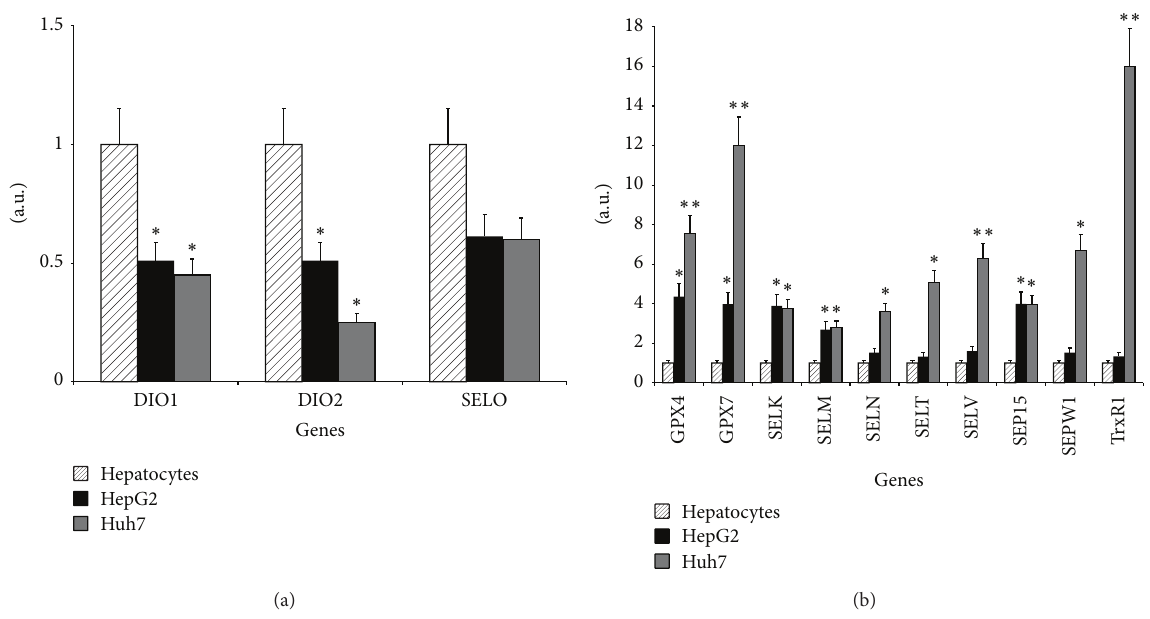
Figure 1: Expression of selenoprotein genes analyzed by means of RT-qPCR. The average value for the expression of these genes was obtained from three independent experiments. (a) shows the downregulated genes in HepG2 and Huh7 versus normal hepatocytes (DIO1, DIO2, and SELO) while (b) shows the ten upregulated genes (GPX4, GPX7, SELK, SELM, SELN, SELT, SELV, SEP15, SEPW1, and TrxR1). In each reaction, the expression levels were normalized to the average of the control gene (18S rRNA) and expressed as arbitrary units. The mRNA levels in hepatocytes, HepG2, and Huh7 were evaluated by using the ΔΔ Ct method. Significant differences in relative gene expression between hepatocytes and HepG2 or Huh7 are marked by ( ∗ 𝑝 value < 0.05) and ( ∗∗ 𝑝 value <